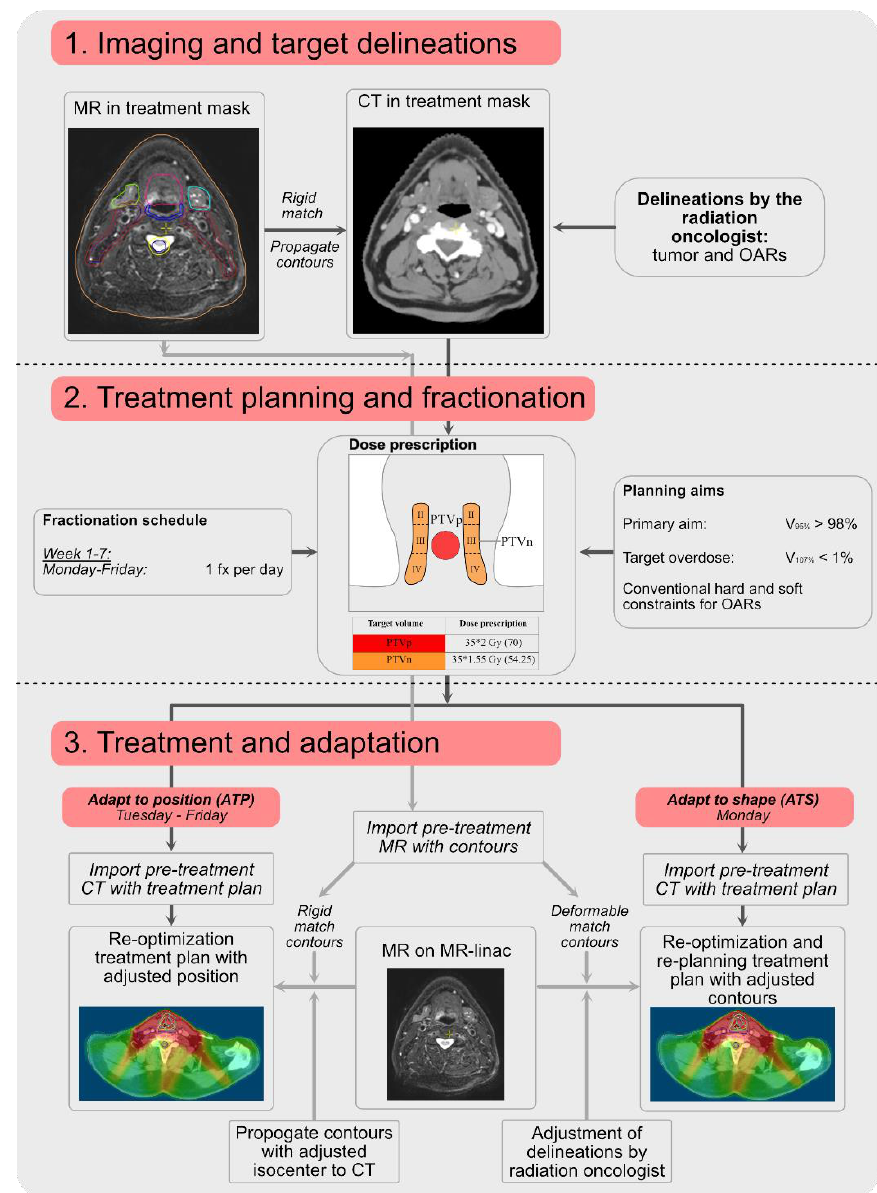
Figure 1. An overview of an adaptive workflow of an HNSCC treatment on an MR-Linac using both adapt to position (ATP) and adapt to shape (ATS). The black arrows point out the trajectory for the CT and the grey arrow for the MRI. Delineations (step 1) are performed by the radiation oncologist (tumor) and radiation therapist (RTT) (OARs). Step 2 is performed by RTT. For step 3, there is a difference between an ATP procedure (fully performed by RTT) and an ATS procedure (registration: RTT; delineation: radiation oncologist; treatment planning: RTT). The medical physicist is supervisor of RTT for planning and registration (on call). This is very user and country dependent.